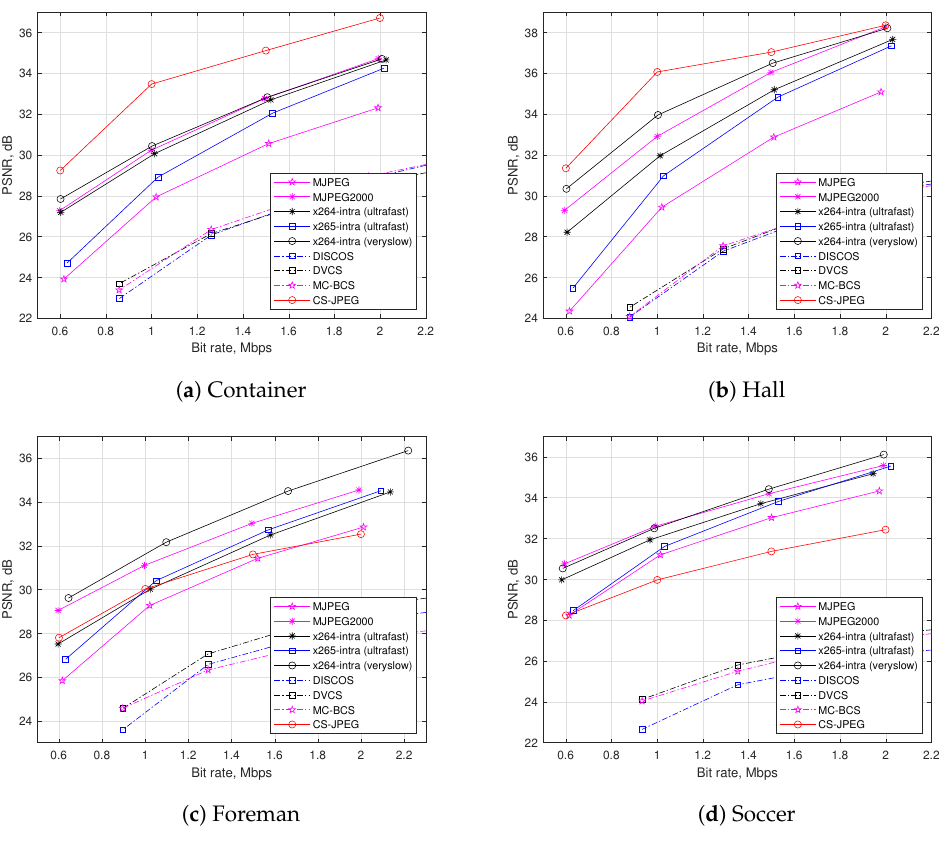
Figure 9. Rate distortion comparison using PSNR metric.